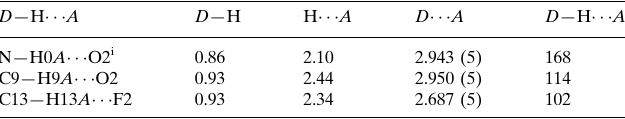
Hydrogen-bond geometry (A˚ , (cid:1)